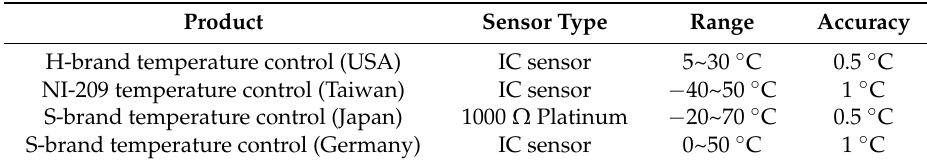
Table 1. Sensors employed by traditional air conditioning system and achieved air conditioning temperature